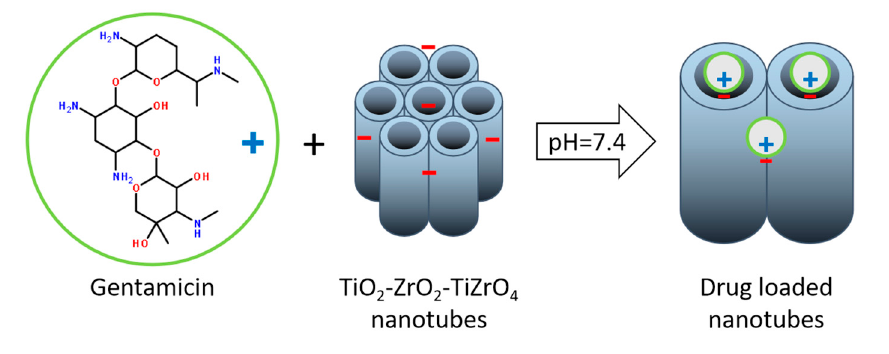
Figure 5. Schematic representation of gentamicin loading on TiO 2 -ZrO 2 -ZrTiO 4 nanotubes via electrostatic interactions.